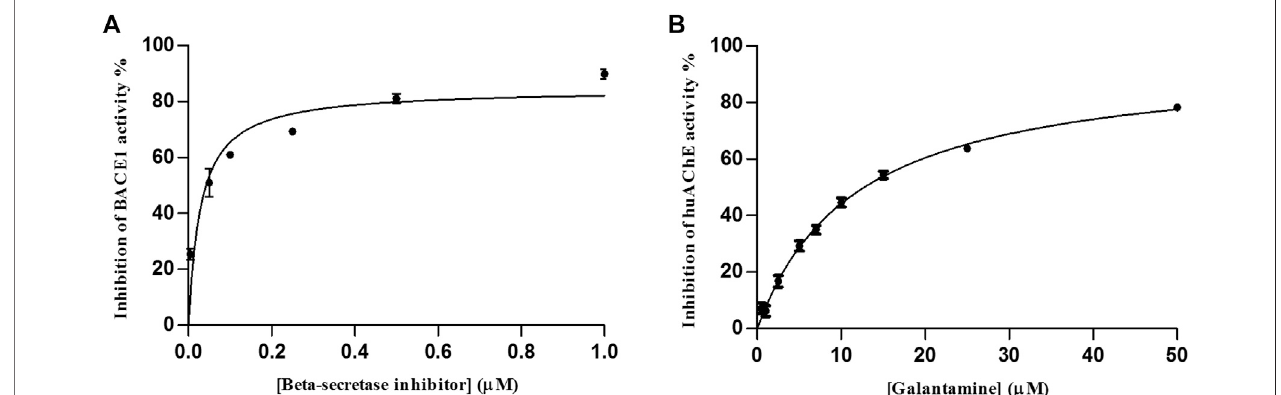
FIGURE 7 | IC 50 curve obtained for huAChE (A) and BACE1 (B) in the huAChE+BACE1-ICER-LC-MS system by using ACh and JMV2236 as substrates, respectively.